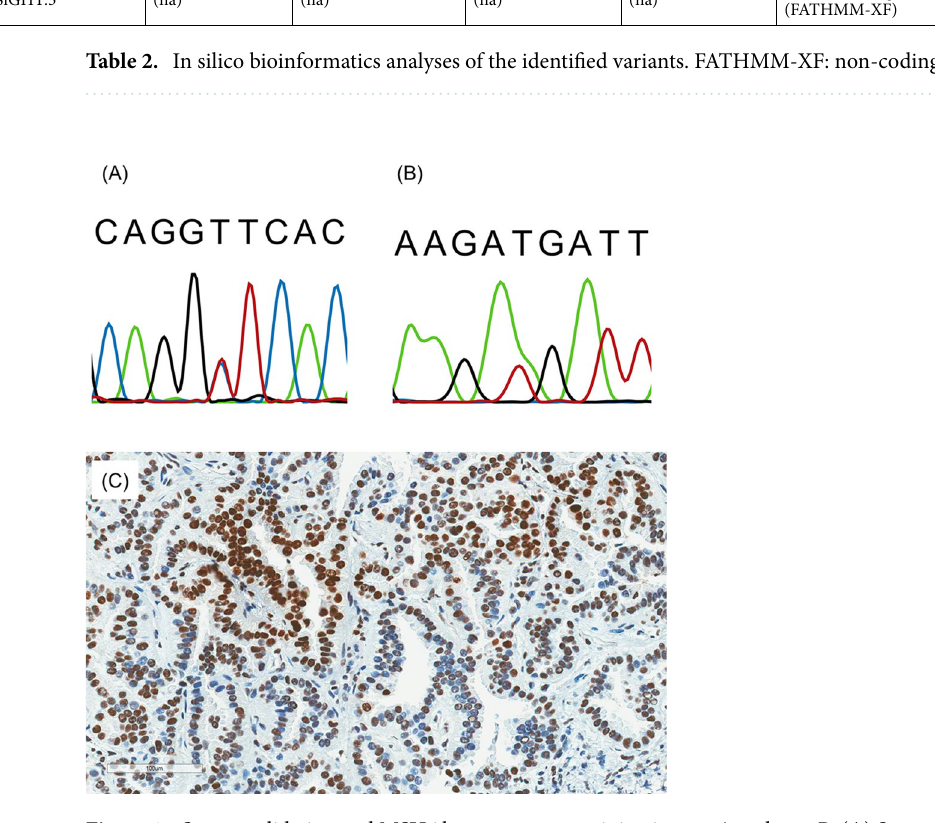
Figure 1. Sanger validation and MSH6 heterogeneous staining in case A and case B. ( A ) Sanger sequencing of the variant (chr2:g.48032109 C>T; NM_000179.2:c.3499 C>T, p.Leu1167Phe), in case A. ( B ) Sanger